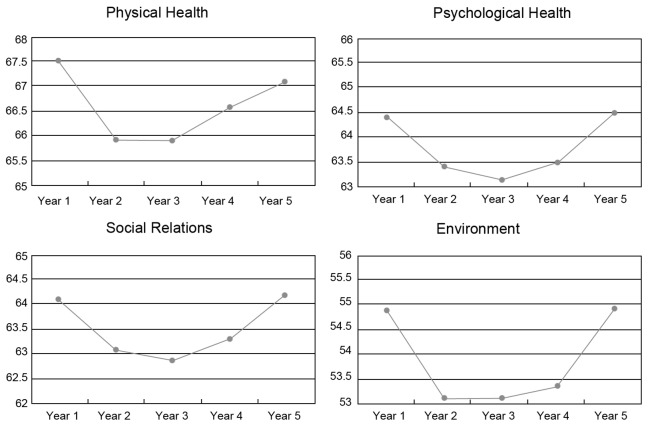
Scores of each domain for preventive medicine.